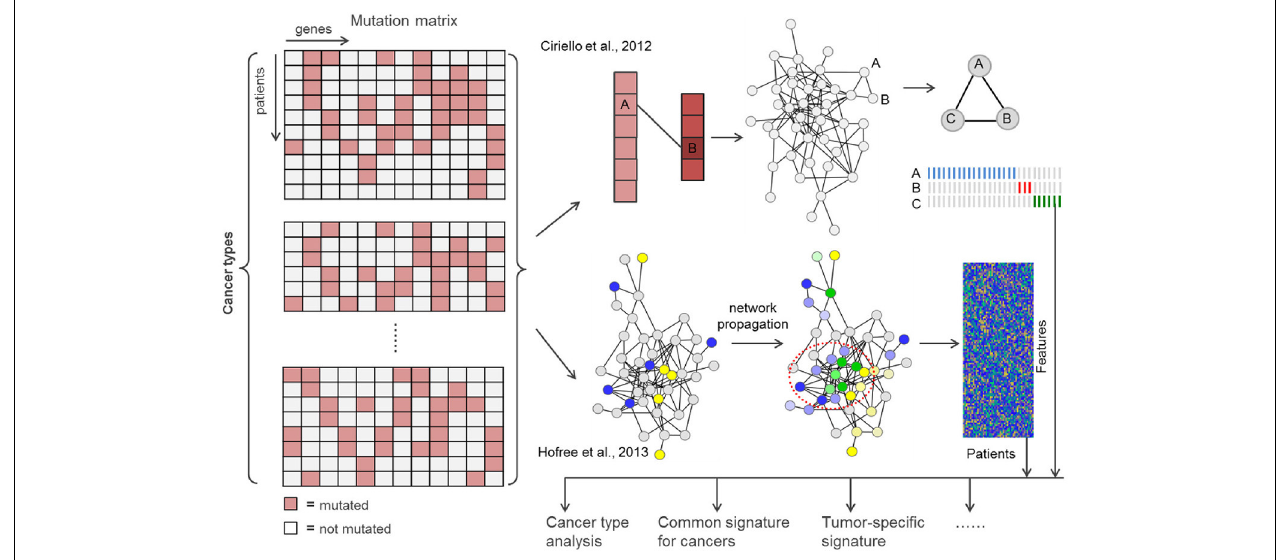
FIGURE 2 | Two potential network-based frameworks for cross-tumor comparative analysis and tumor-specific feature